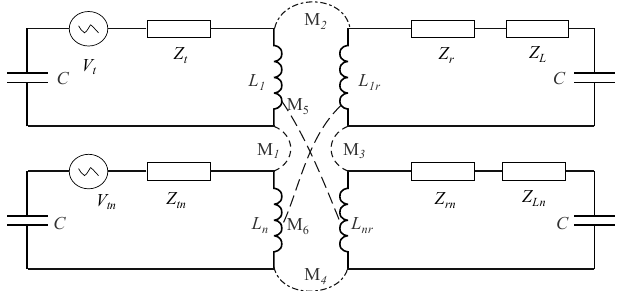
Figure 3. N × N MIMO Schematic diagram of the equivalent circuit. Figure 3. NxN MIMO Schematic diagram of the equivalent circuit.